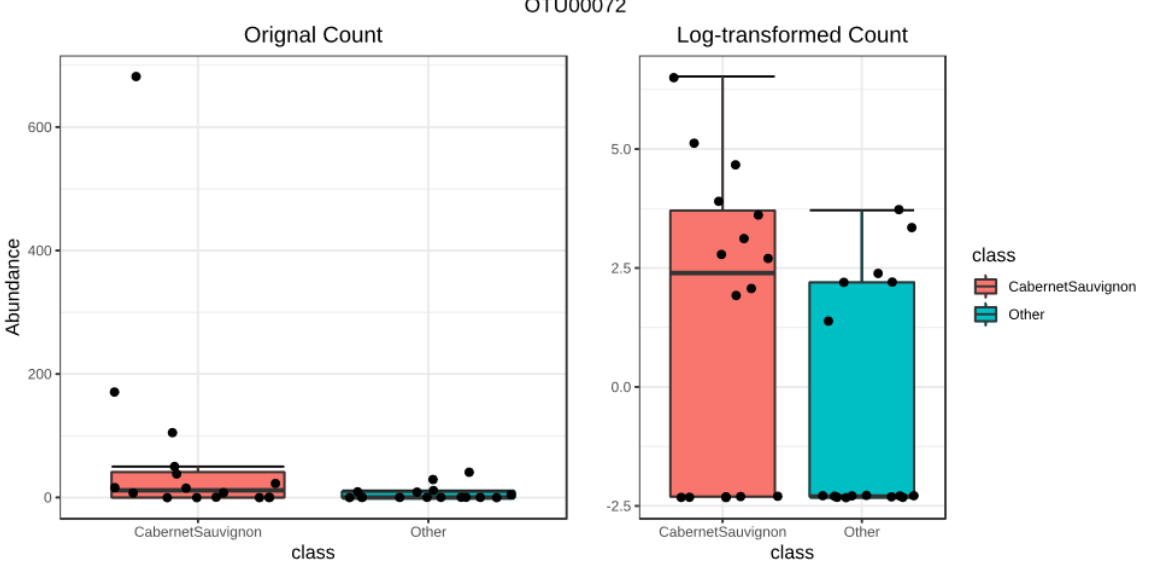
Figure A5. Statistically differentially abundant OTUs between Cabernet Sauvignon and local cultivars. Data transformed using the R package EdgeR, adjusted p − value cutoff, 0.05. The black solid line inside the box is the median value and the black dots are individual samples.